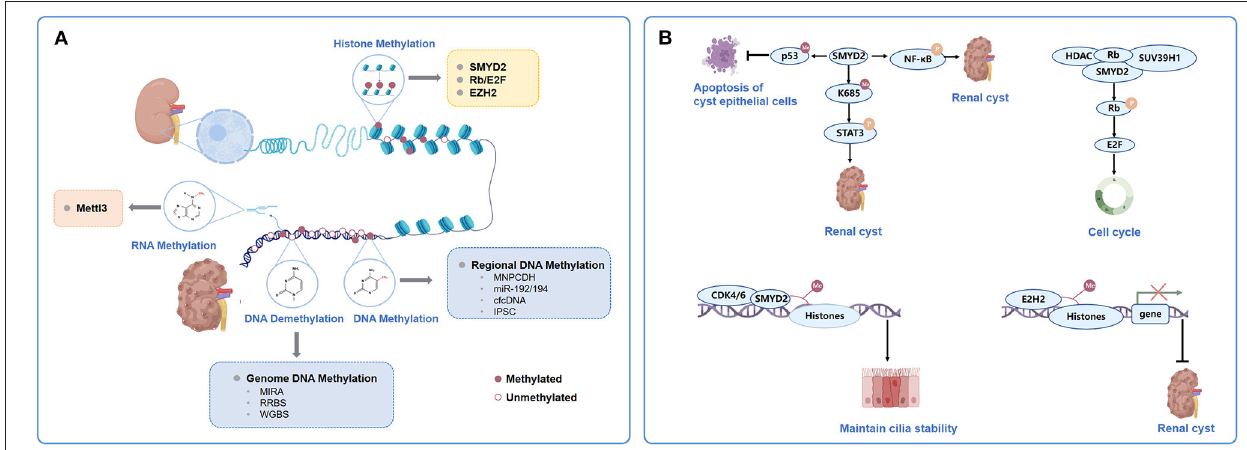
FIGURE 1 | Major types and mechanism of chromatin methylation in ADPKD. (A) . Categorization of chromatin methylation in ADPKD. The chromatin methylation in ADPKD mostly involves DNA methylation, histone methylation and RNA methylation. Genome-wide platforms to detect DNA methylation in ADPKD including MIRA, RRBS and WGBS. Genome hypomethylation and gene hypermethylation coexist in ADPKD. Regional DNA methylations could predict application as biomarkers in ADPKD, such as methylation of MUPCDH, miR-192/194, cfcDNA and iPSC. Histone methylations were mediated by HMTs. Some of the mediators and modulators to be closely related to the pathogenesis and acceleration of cystic phenotypes together with or acting as the HMTs, mainly represented by SMYD2, Rb/E2F and EZH2. The adenosine methylation at the 6th nitrogen position known as m6A, mediated by the multi-protein m6A writer complex composed of Mettl3, was involved in pathogenesis of mouse and human ADPKD. (B) Participation of SMYD2, Rb/E2F and EZH2 in histone methylation in ADPKD. ADPKD, autosomal dominant polycystic kidney disease; MIRA, methylated- CpG Islandisland recovery assay; RRBS, reduced representation bisulfitebisulphite sequencing; WGBS, whole-genome